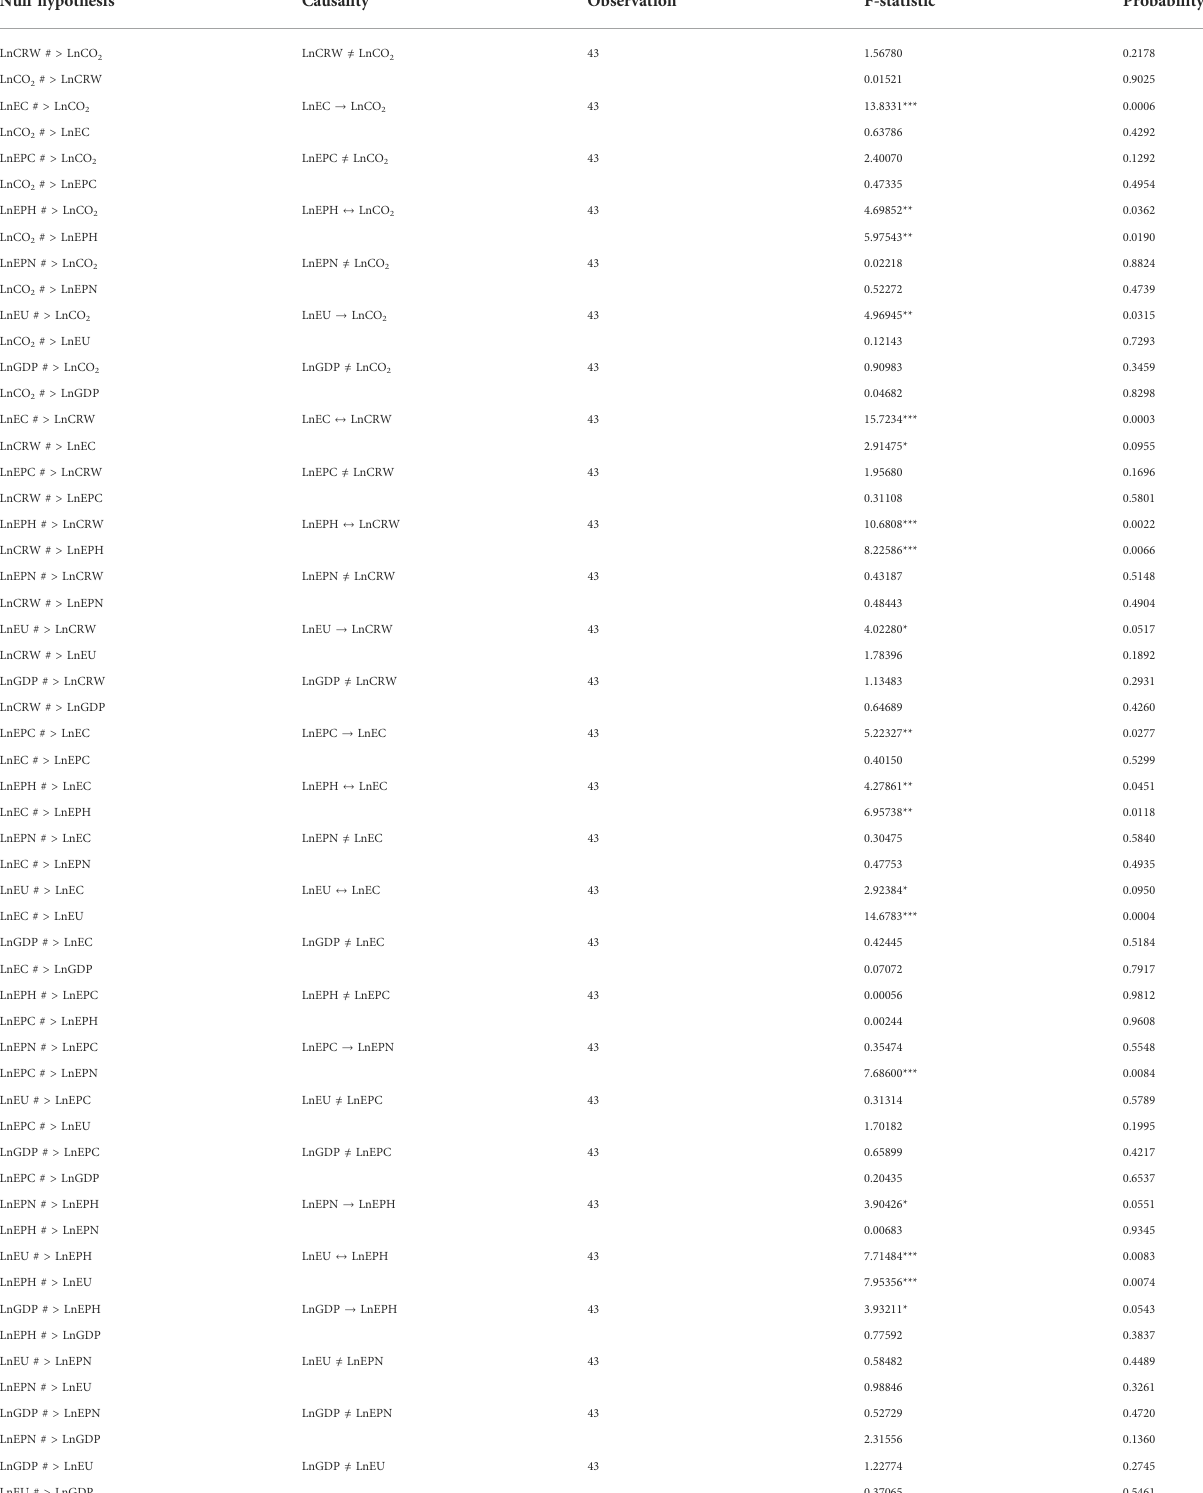
TABLE 12 Pairwise Granger causality